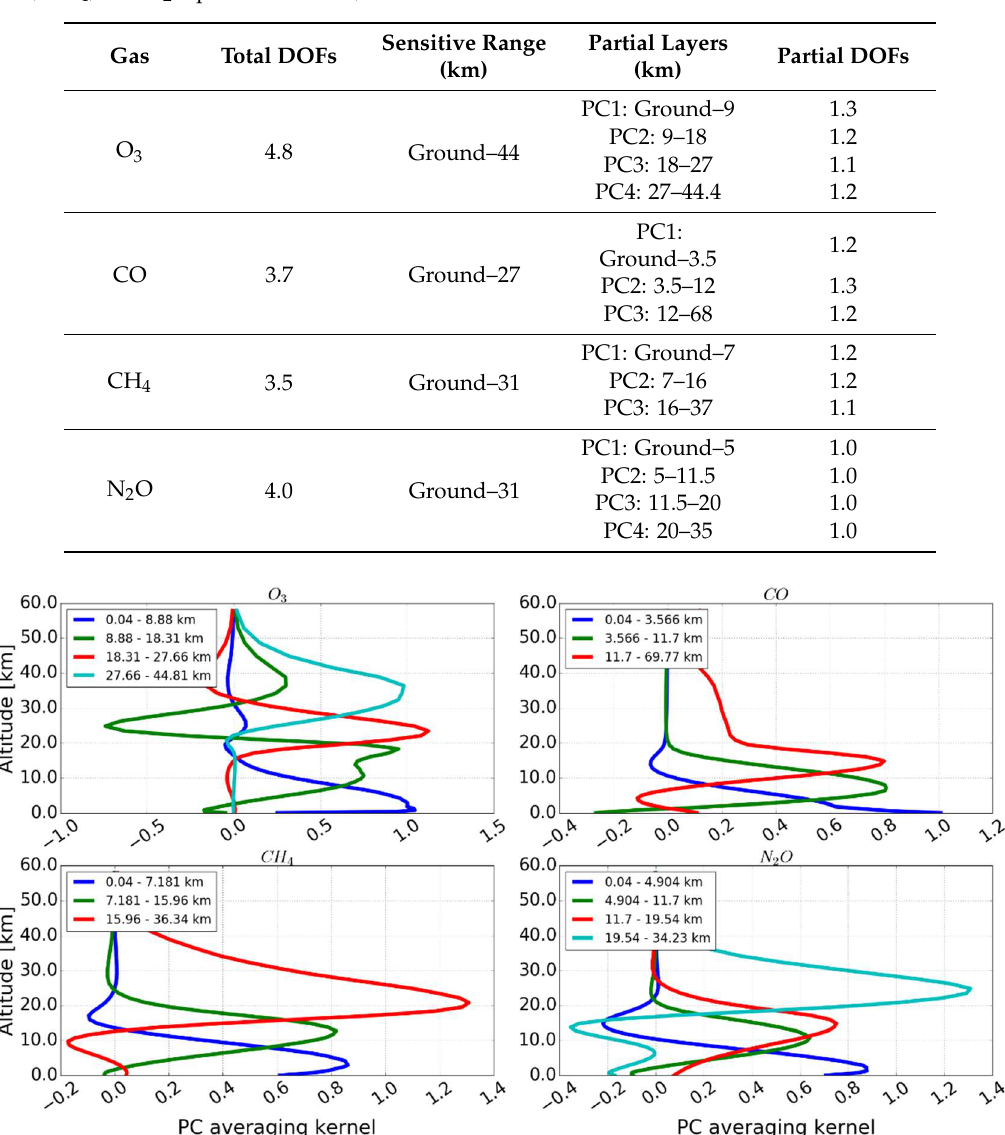
Table 2. Typical degrees of freedom (DOFs) for the signal and sensitivity ranges of the retrieved O 3 , CO, CH 4 , and N 2 O profiles in Hefei, China.